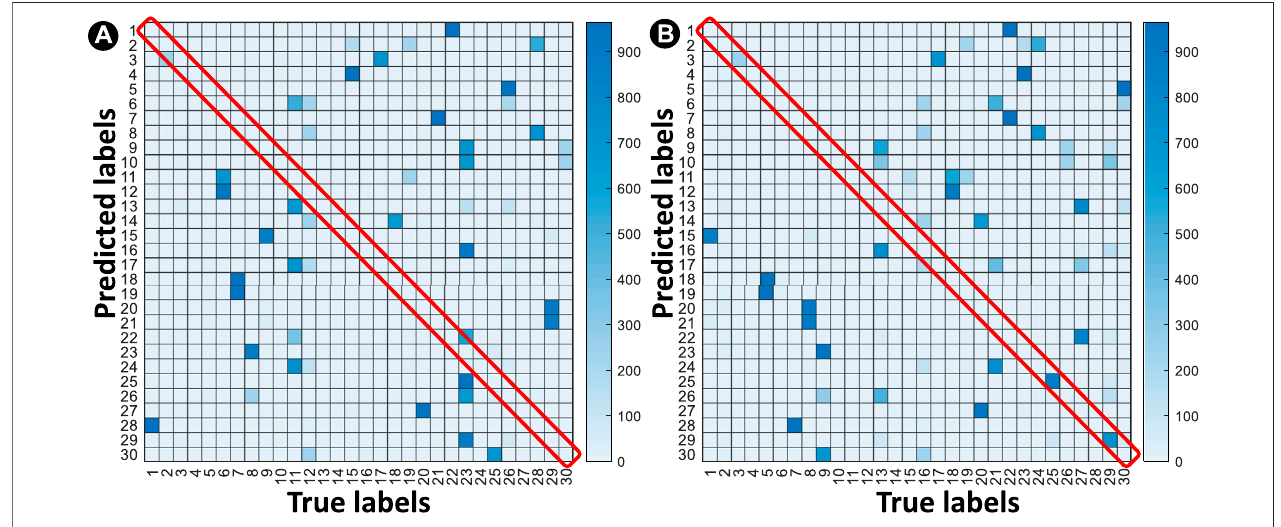
FIGURE 9 | Heatmap ofunsupervised learning in the attacker using k-means clustering. (A) The worst-case accuracy of 0.09 % and (B) the best-case accuracy of 6.8 % . Repeated clustering 1000 times shows 3.63 % accuracy on average.